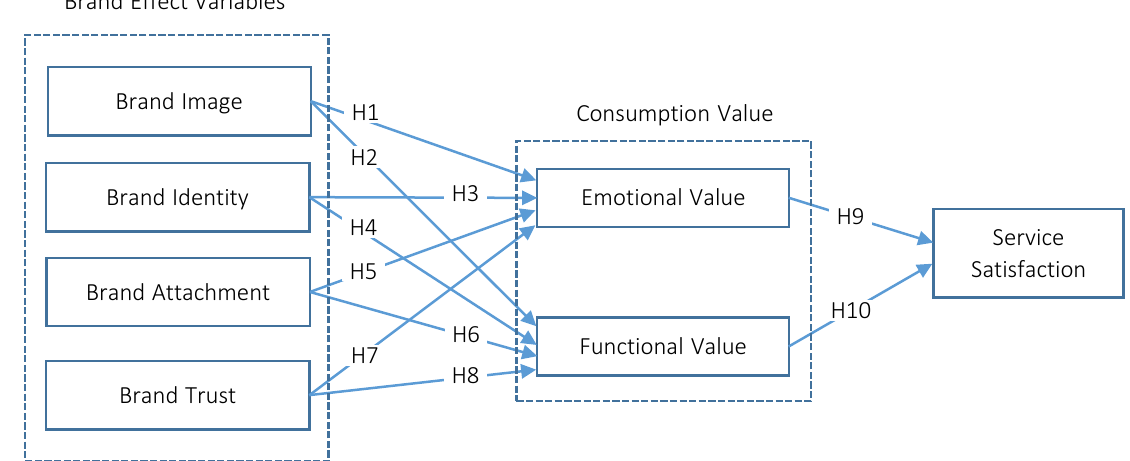
Figure 1. Research